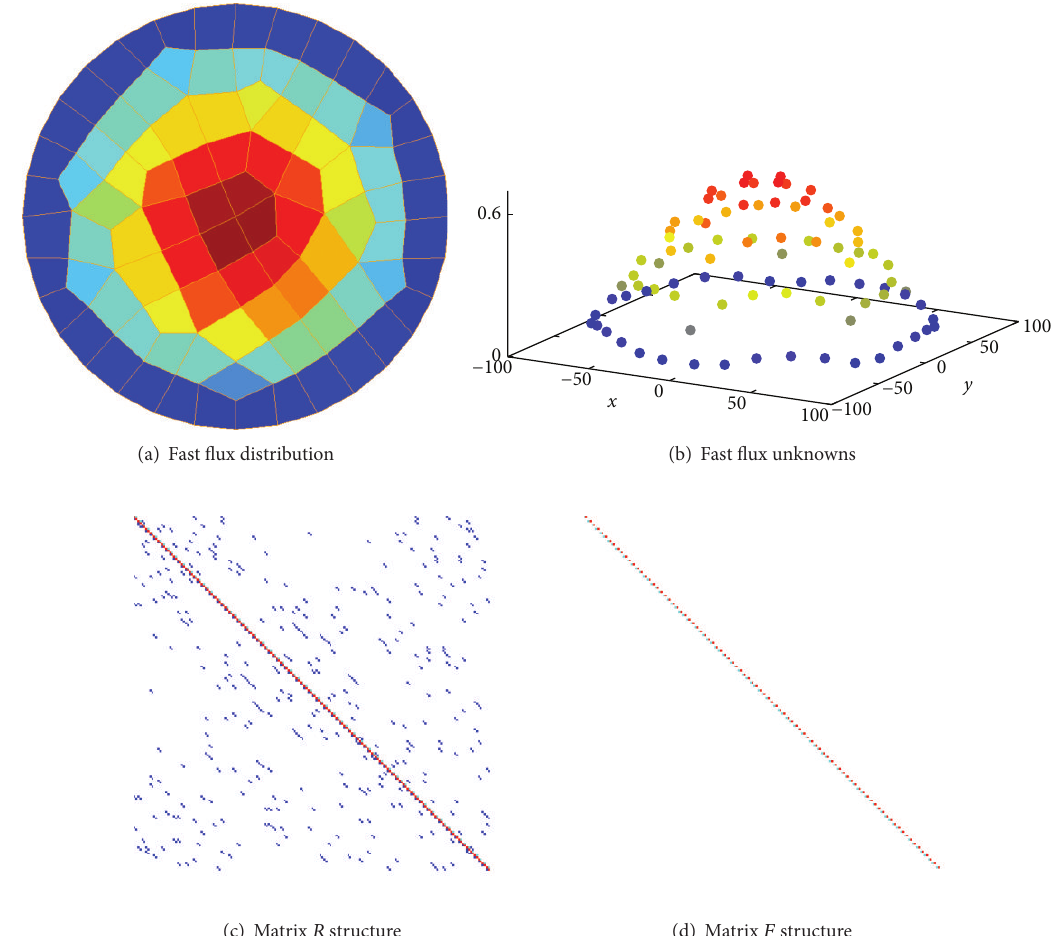
Figure 5: A bare homogeneous circle solved with finite volumes (184